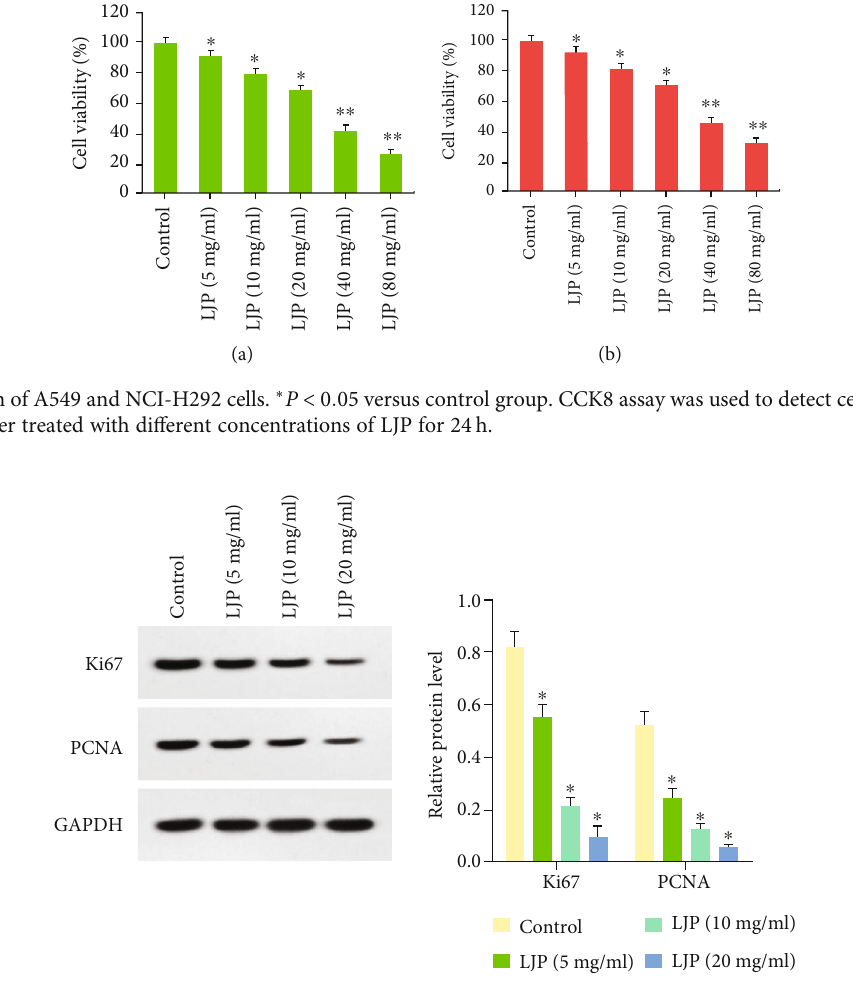
Figure 4: Expressions of Ki67 and PCNA. ∗ P < 0 : 05 versus control group. Western blot assay was used to detect expressions of Ki67 and PCNA after treated with di ff erent concentrations of LJP for 24 h.